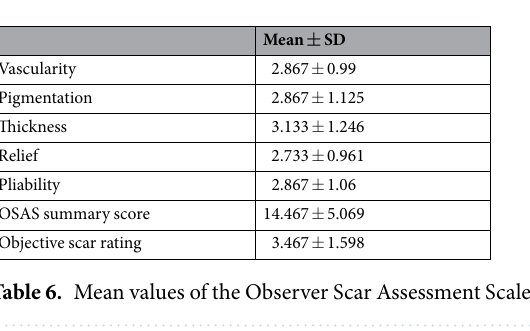
Table 5. Summary of the tensiometer data. N, Newton; All variables, difference of paired variables, and rate of change were expressed as Mean ± SE, p value computed using Wilcoxon signed-rank test.